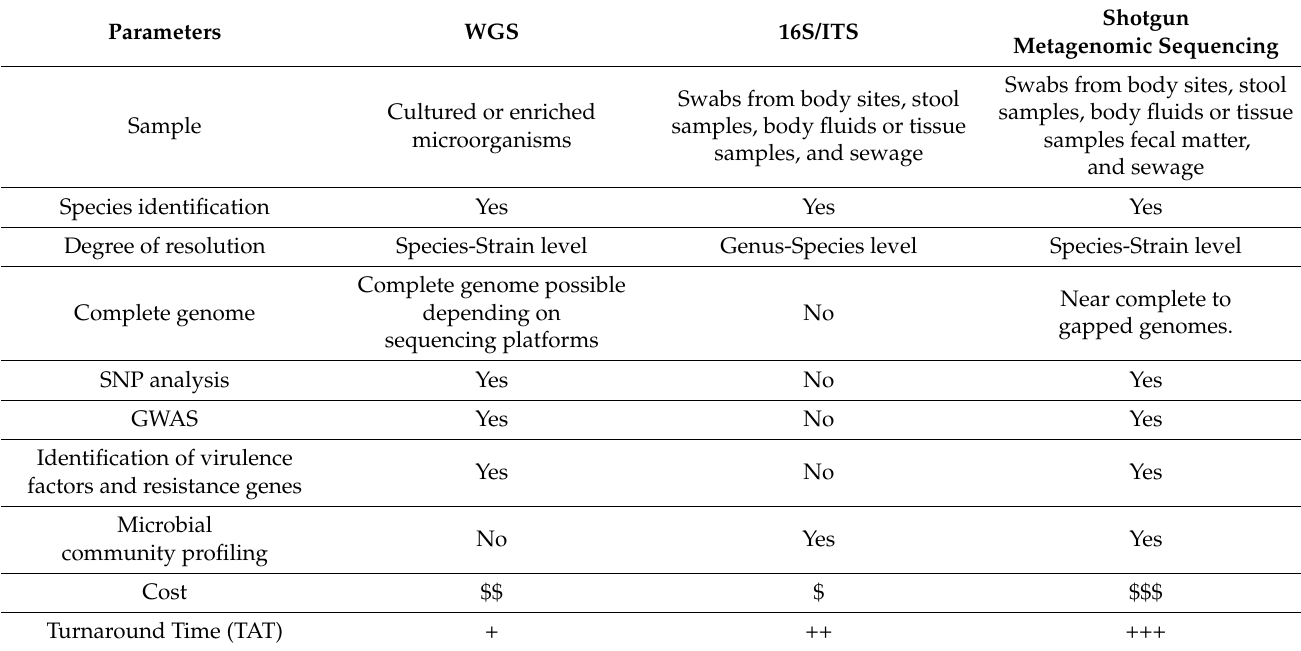
Table 1. Comparison of whole-genome sequencing, marker gene-based amplicon sequencing, and shotgun metagenomic sequencing. GWAS = Genome-Wide Association Studies. SNP = Single Nucleotide Polymorphism. The symbol “$” represents the cost of sequencing. Higher number of $ = higher cost. The symbol “+” represents the turnaround time for the sequencing strategies. Higher number of + = longer turnaround